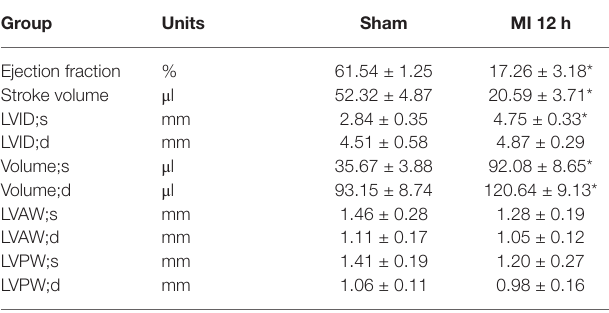
TABLE 2 | Echocardiography results of the study